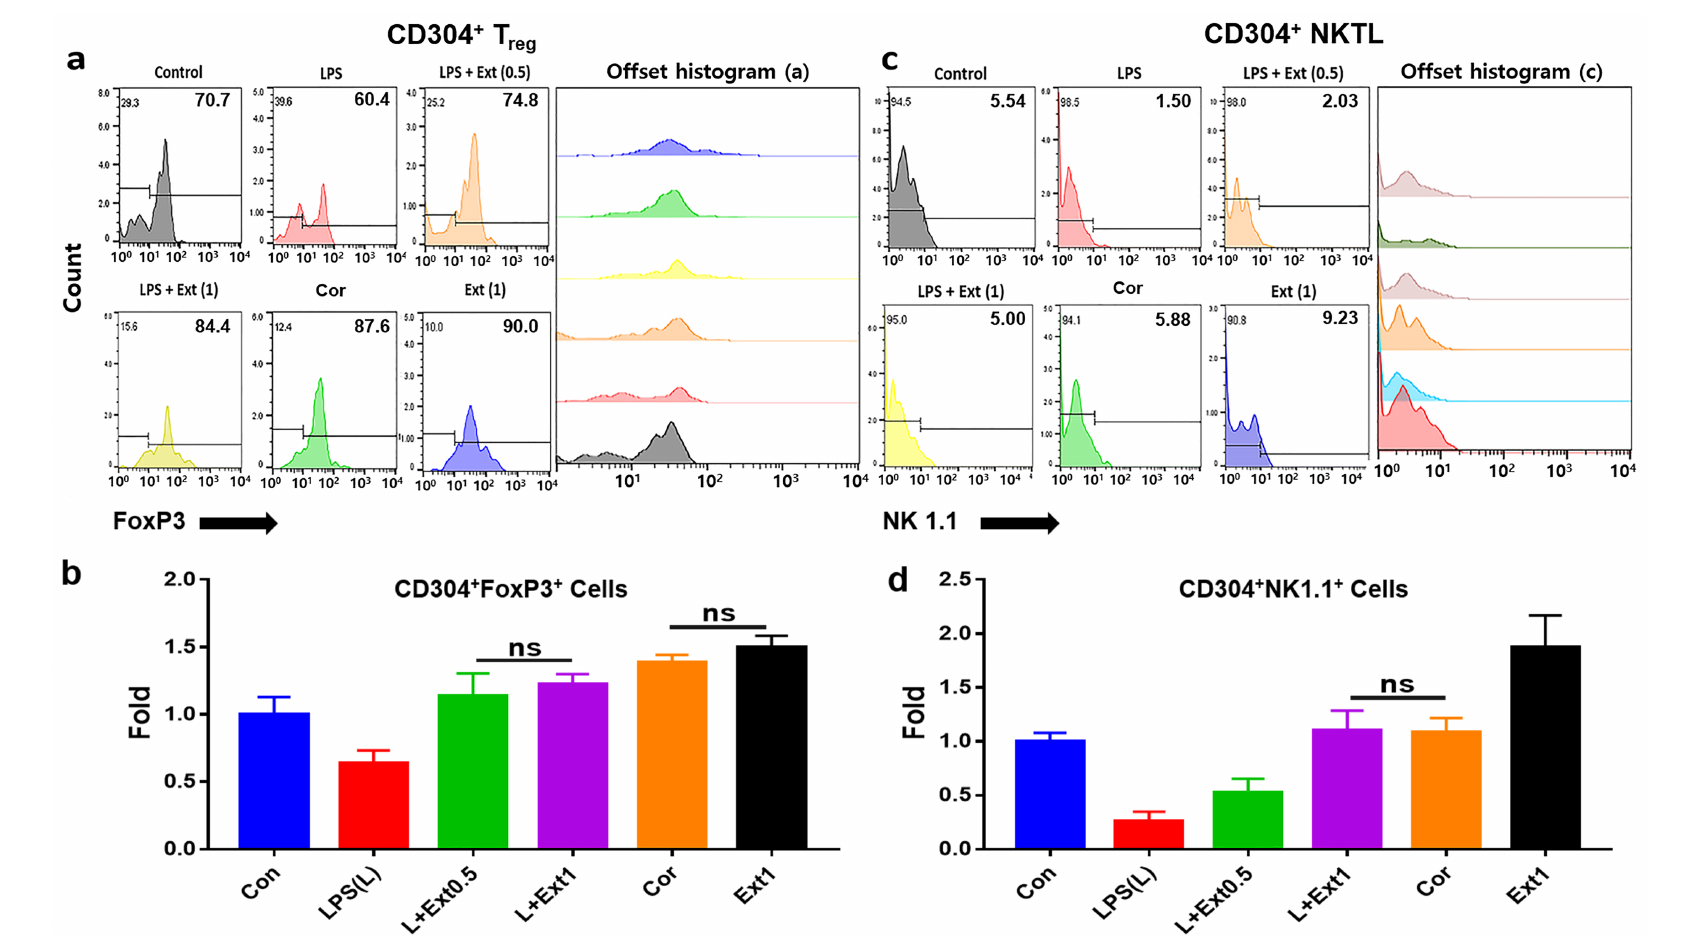
Figure 7. Lymphocyte differentiation by activated macrophages in the various conditioned media. After gating with CD304, the gated cells were distinguished from CD304 + T reg and natural killer T-like (NKTL) cells through expression of FoxP3 and NK1.1. Differentiated lymphocytes were counted by flowcytometry and were analyzed using the FlowJo software 10.6.1. Panels ( a , b ) show the density of CD304 + FoxP3 + cells under various conditions as follows: LPS only, extract 0.5 µ g/mL and 1 µ g/mL (Ext 0.5, 1), followed by LPS treatment, cordycepin, and extract. Panels ( c , d ) show the density of CD304 + NK1.1 + cells under the same conditions. LPS; lipopolysaccharide, Ext; extract, Cor; cordycepin, ns; not significant ( p <